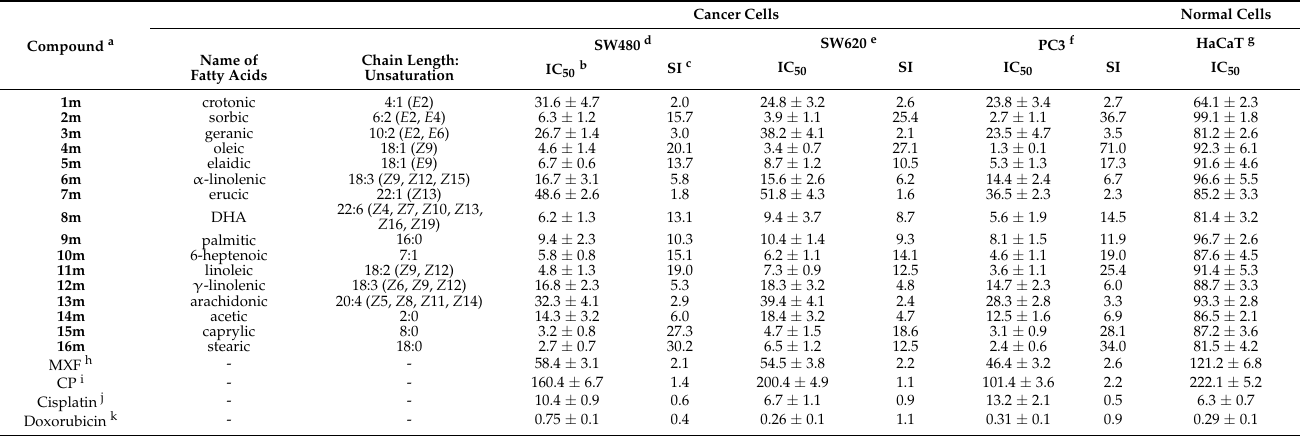
Table 1. Cytotoxic activity (IC 50 , µ M) of studied compounds estimated by the MTT assay. Data are expressed as mean ± SD; a respective MXF conjugates; b IC 50 ( µ M)—the concentration of the compound that corresponds to a 50% growth inhibition of cell line as compared to the control after cultured the cells for 72 h with the individual compounds. c The SI (selectivity index) was calculated using formula: SI = IC 50 for normal cell line/IC 50 cancer cell line. d Human primary colon cancer (SW480); e human metastatic colon cancer (SW620); f human metastatic prostate cancer (PC3); g human immortal keratinocyte cell line from adult human skin (HaCaT); h moxifloxacin; i ciprofloxacin; j,k reference compounds commonly used in cancer